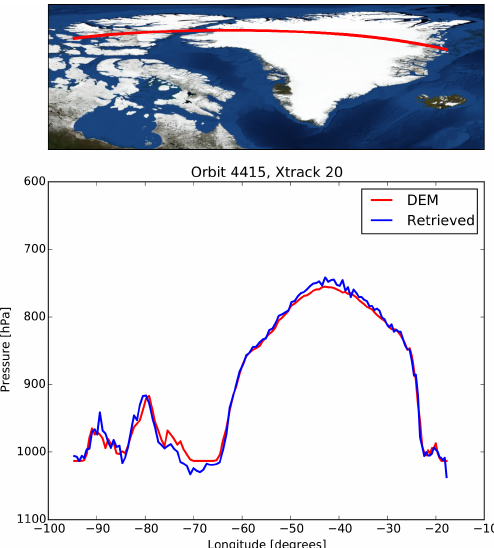
Figure 9. Top panel: map of the position of the ground pixel centres. Bottom panel: comparison of the retrieved scene pressure and the surface pressure derived from the DEM, plotted as a function of the